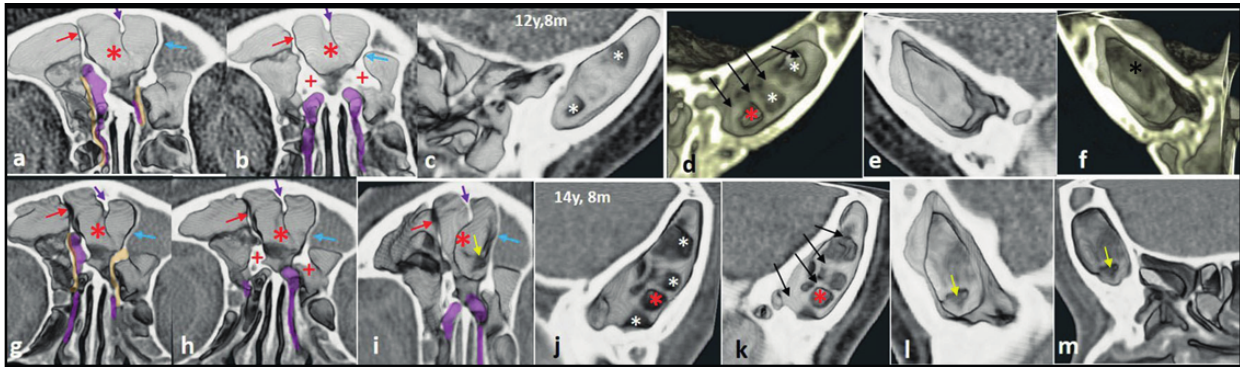
Figure 9. Inter-Frontal Sinus Septal Cell (IFSSC): development over a course of two years. a.-f. 3D images of a 12-year, 8 month old patient. 3D coronal images (a., b., with b. being Inferior to a.), reveal that the antero-superior extension of the MM bilaterally (purple outline), is accompanied by the anterosuperior extension of the UL laterally and the MT medially, which fuse anterior to the MM termination. The fusion of the UP and MT continues forward to the anterior frontal sinus wall, as a “common lamella”, creating a left paracentral septation (red arrow). A right para-central septation is created by the extension of the UL (gold outline) (fig. a.). Note in fig. (b.) the two posterior para- central lamellae adhere at a bony groove arising from the antero-inferior FS (red +). In both (figs. a., b.), an anterior bony ridge (purple arrow) is noted in the floor of the central space, i.e. the IFSSC (red